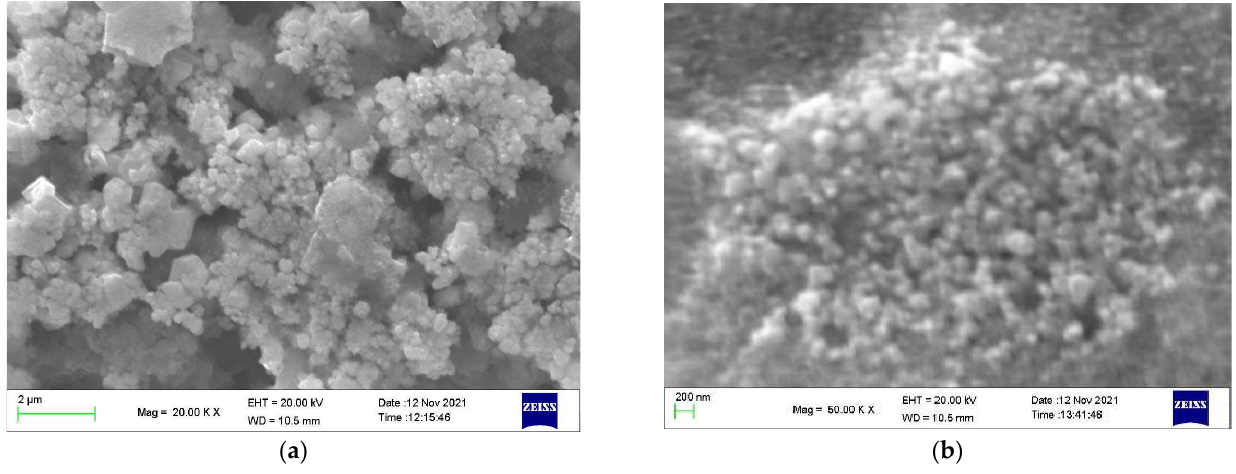
Figure 4. SEM image of AgNPs-LCg ( a ) and AgNPs-FCg ( b ) displayed at 20,000× and 50,000× mag- nification, respectively.